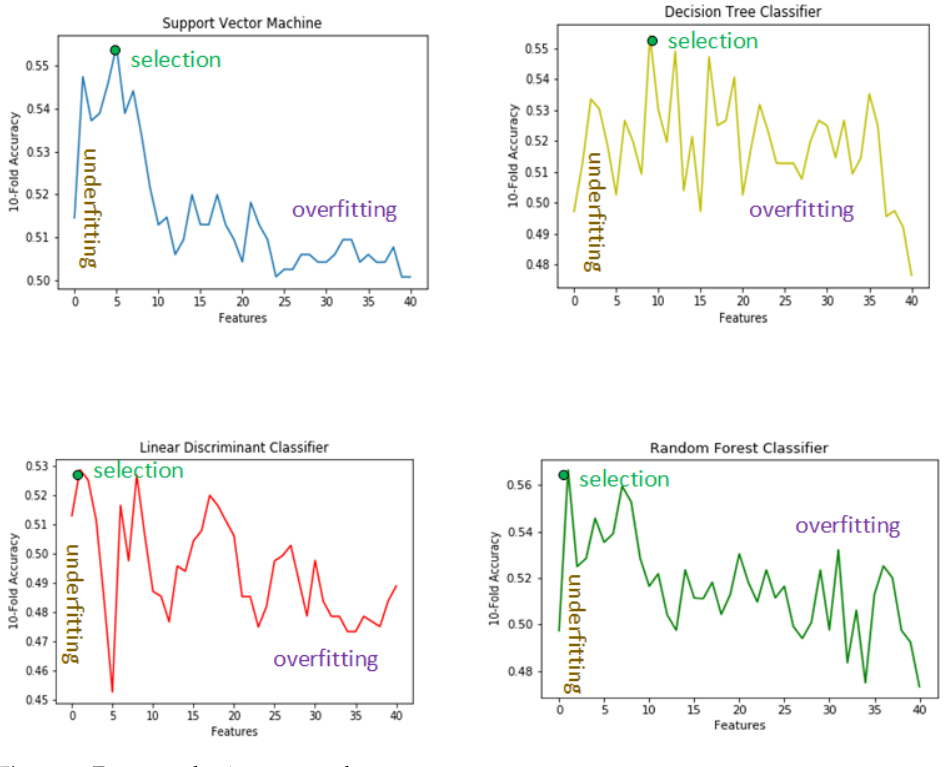
Figure 2. Feature selection